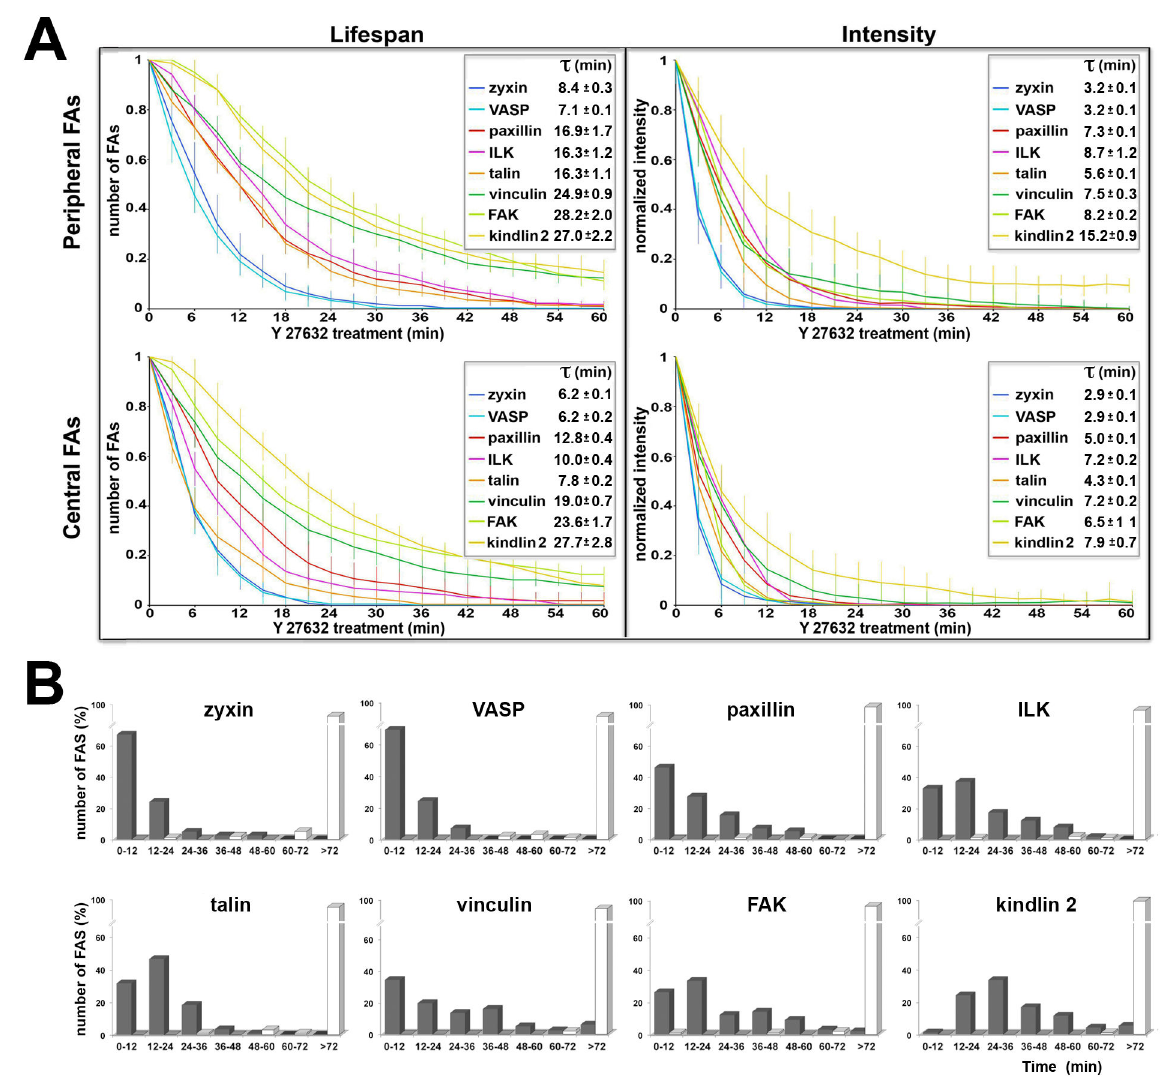
Figure 3. Differential dissociation rates of adhesome components in cells treated with Y-27632. ( A ) FA lifespan (expressed as the relative number of surviving FAs) and average normalized fluorescence intensity for each protein, in peripheral and central FAs separately, as tracked by time-lapse video microsopy for a hundred individual FAs. τ values were calculated by fitting the individual decay profiles to a single-exponential function. Note that the order of exit of the different molecules is the same in all graphs, with zyxin and VASP as the first to leave and kindlin 2 as the last. ( B ) Based on the same dataset shown in A , the differential effect of Y-27632 on the lifespan of the FA proteins tested, in peripheral FAs, is shown for each protein, separately. FA lifespan for each protein is expressed as the percentage of total FA number over time. Untreated cells are shown as white columns; cells treated with Y27632 as black